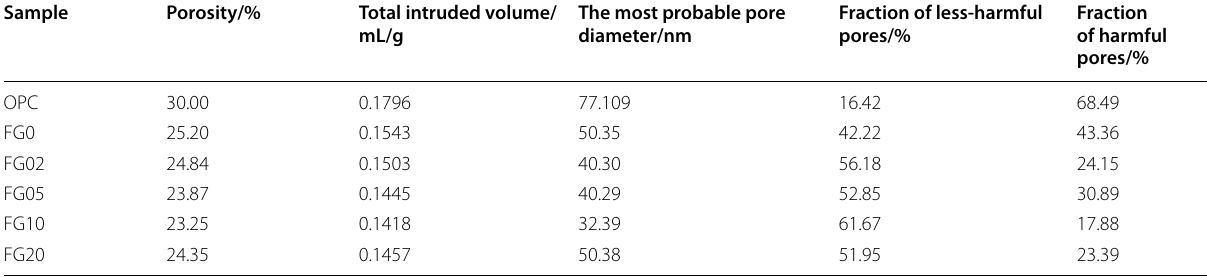
Table 4 MIP results of fly ash cement paste with different amounts of 3DG. Sample